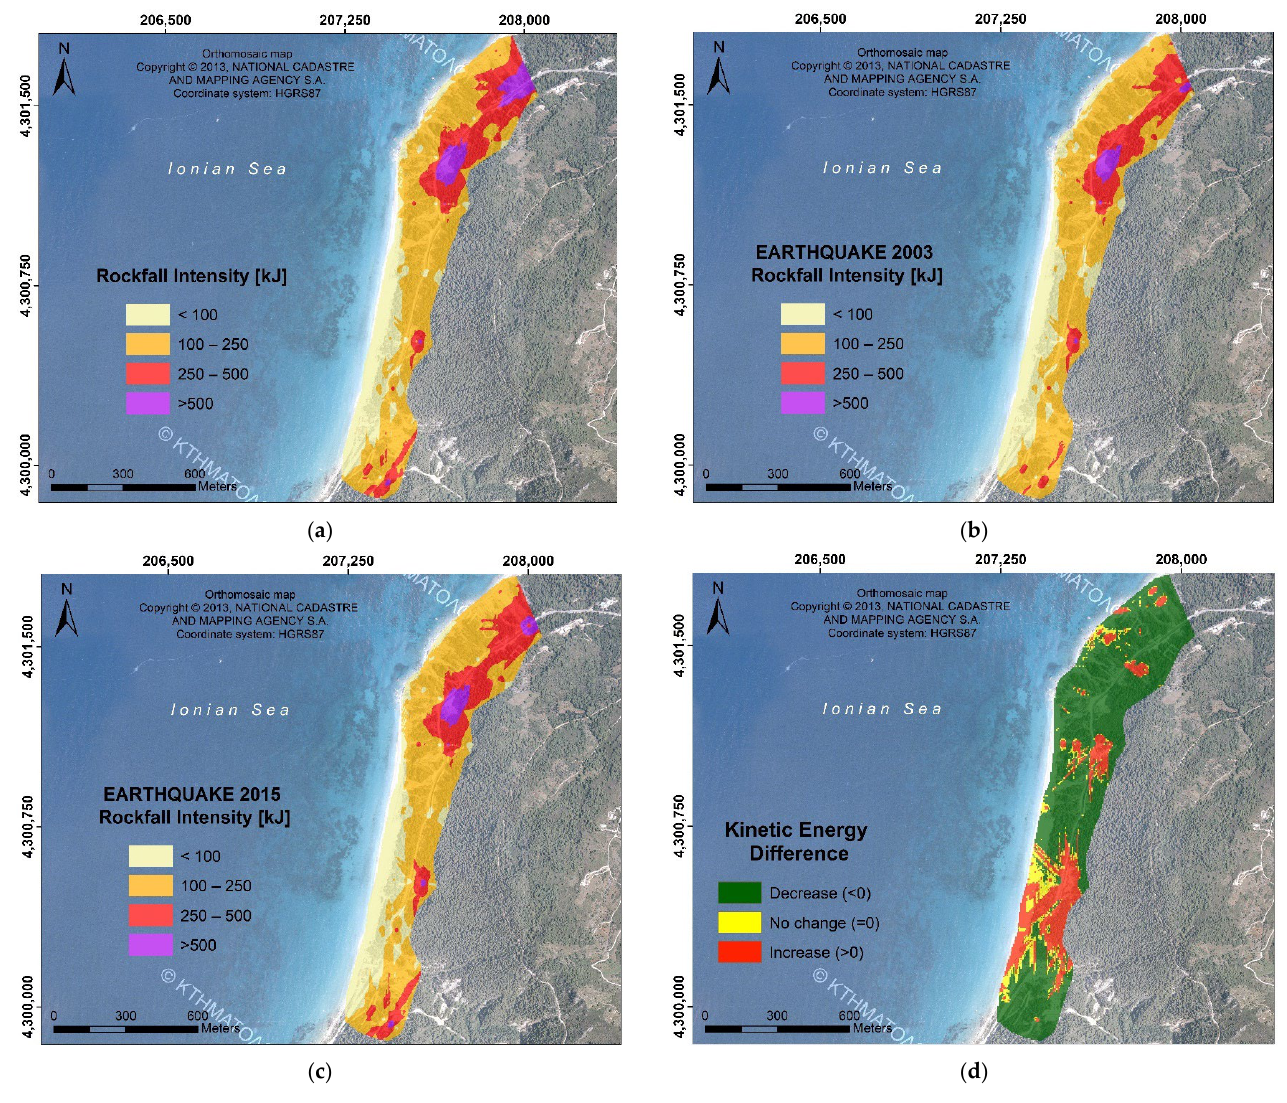
Figure 10. Rockfall intensity maps of area A, with ( a ) Vo = 0, ( b ) Vo = 0.80 m/s, ( c ) Vo = 0.65 m/s, and ( d ) difference in the kinetic energy distribution between ( a and b ).